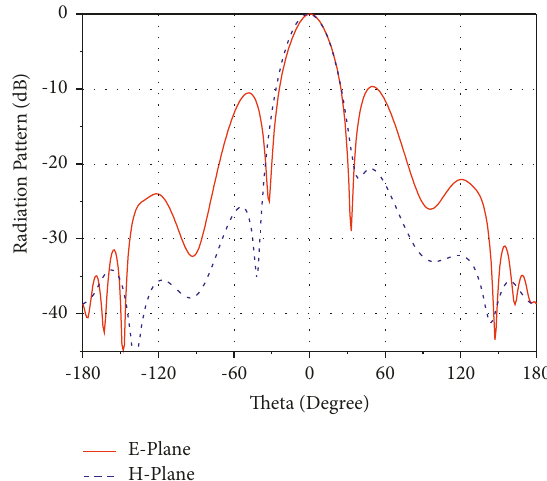
Figure 6: Radiation patterns of antenna element at 26.9GHz.